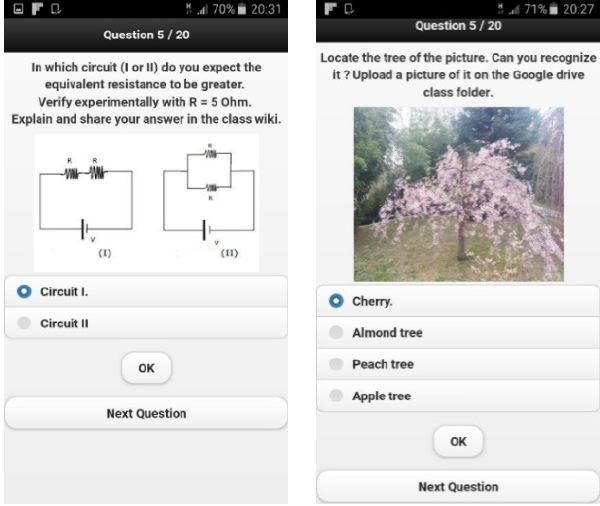
Figure 6. Screenshots of the mobile-based formative assessment.